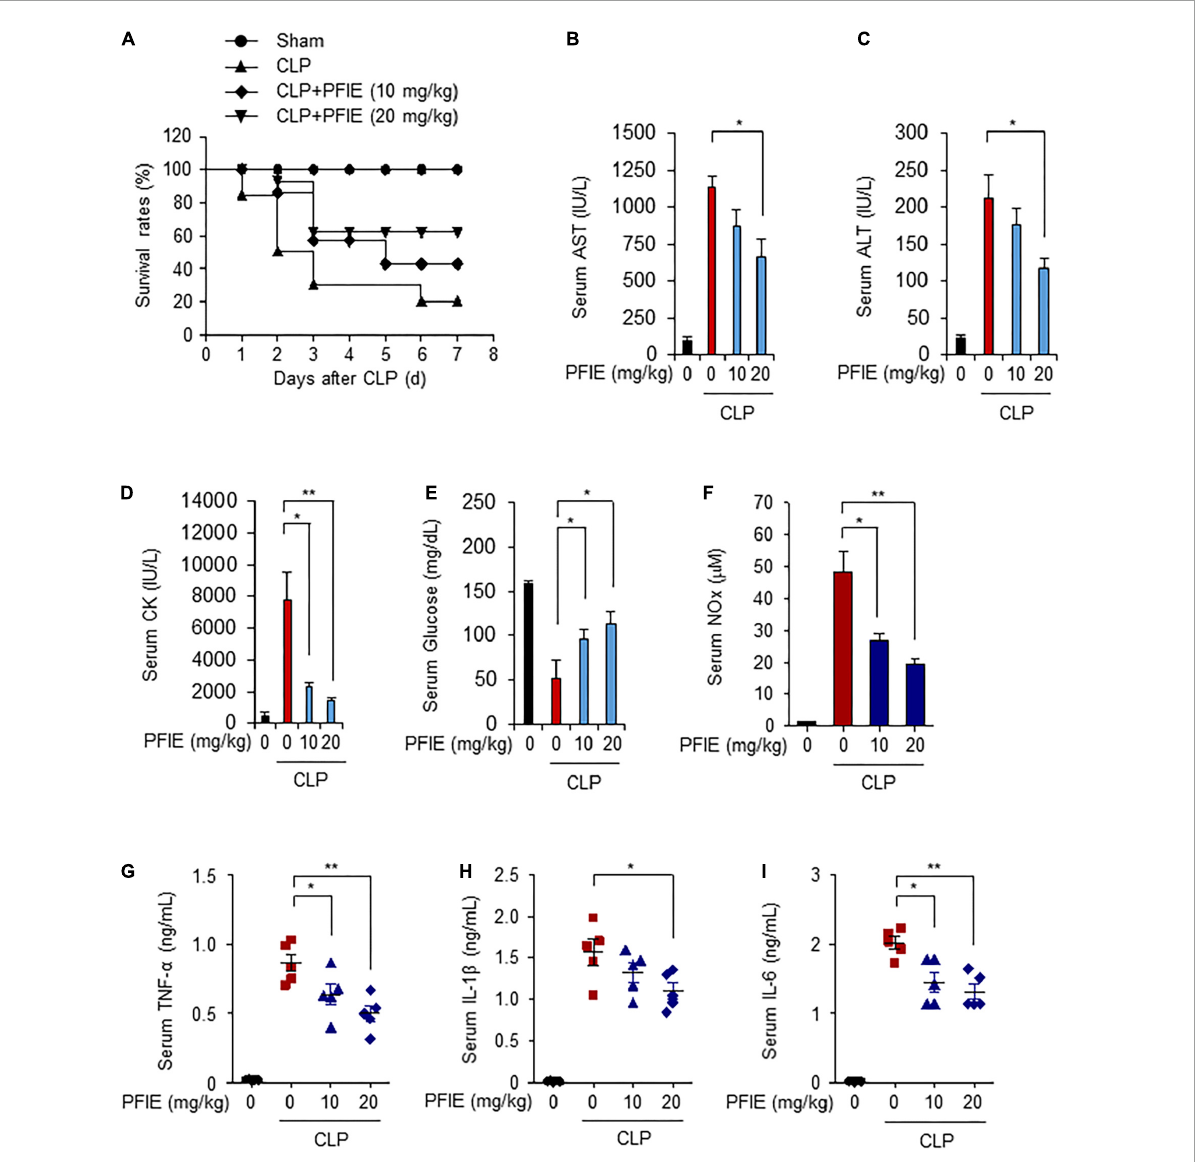
FIGURE5 PFIE improves the survival rate and attenuates proinflammatory responses in a CLP-induced septic mouse model. (A) Mortality was monitored for 7 days after the surgery ( n = 10): sham (circle); CLP (triangle); CLP + 10 mg/kg of PFIE (inverted triangle); CLP + 20 mg/kg of PFIE (diamond). (B–I) Mouse serum samples ( n = 5) were collected 12 h after CLP. Serum levels of AST (B) , ALT (C) , and CK (D) measured using an automatic chemical analyzer. (F) Serum levels of nitric oxide (NO) metabolites measured using Griess reagent. Serum levels of TNF- α (G) , IL-1 β (H) , and IL-6 (I) measured using ELISA. * P < 0.05 and ** P < 0.01 (Student’s t